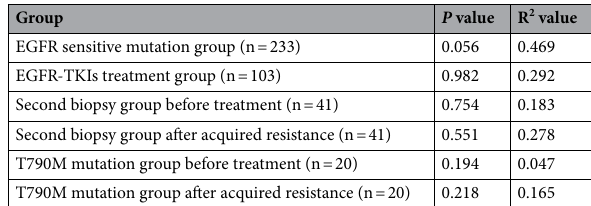
Table 6. Pearson’s correlation analysis between tumor diameter and HIF-1α level.